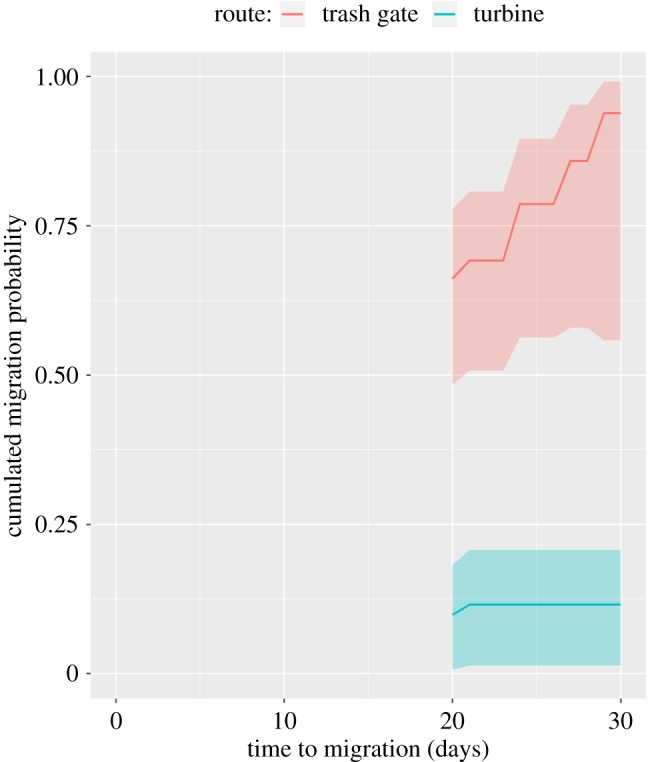
Prediction plot for the cumulated migration probabilities for the selected Cox proportional hazards model focusing on the ‘after trash gate opening’ period. Trash gate and turbine migrants are plotted only, as no migrants used floodgate alternatives during this period. The plotted trajectories are for individuals that were released the day before opening the trash gate. Shaded areas correspond to 95% confidence bounds.